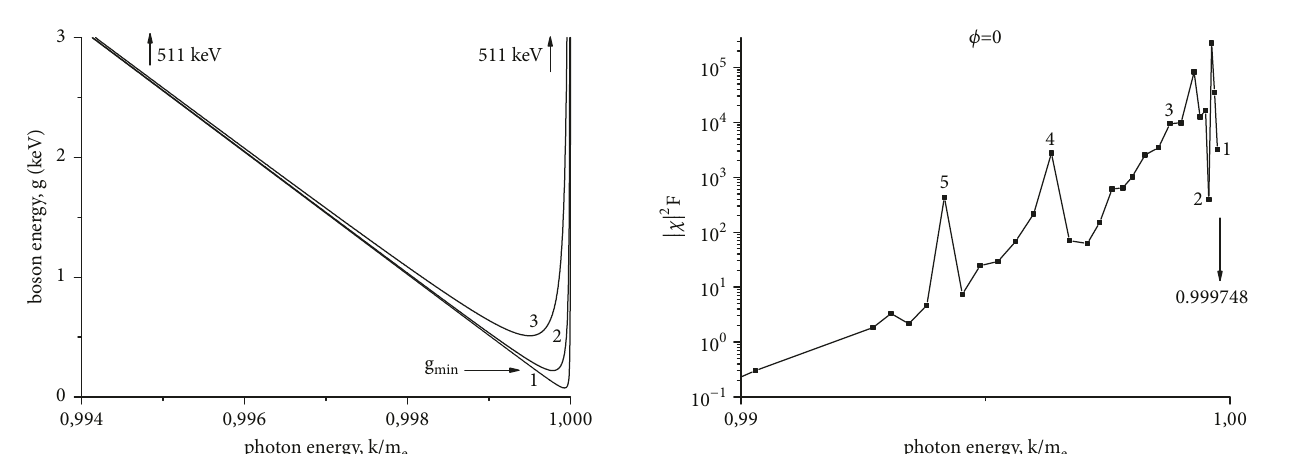
Figure 5: The photon energy dependence of the boson energy at given angle between the photon wave vectors. For the curves from 1 to 3, 1: 𝜙 = 0.146 mrad; 2: 𝜙 = 0.431 mrad; 3: 𝜙 = 1 mrad.